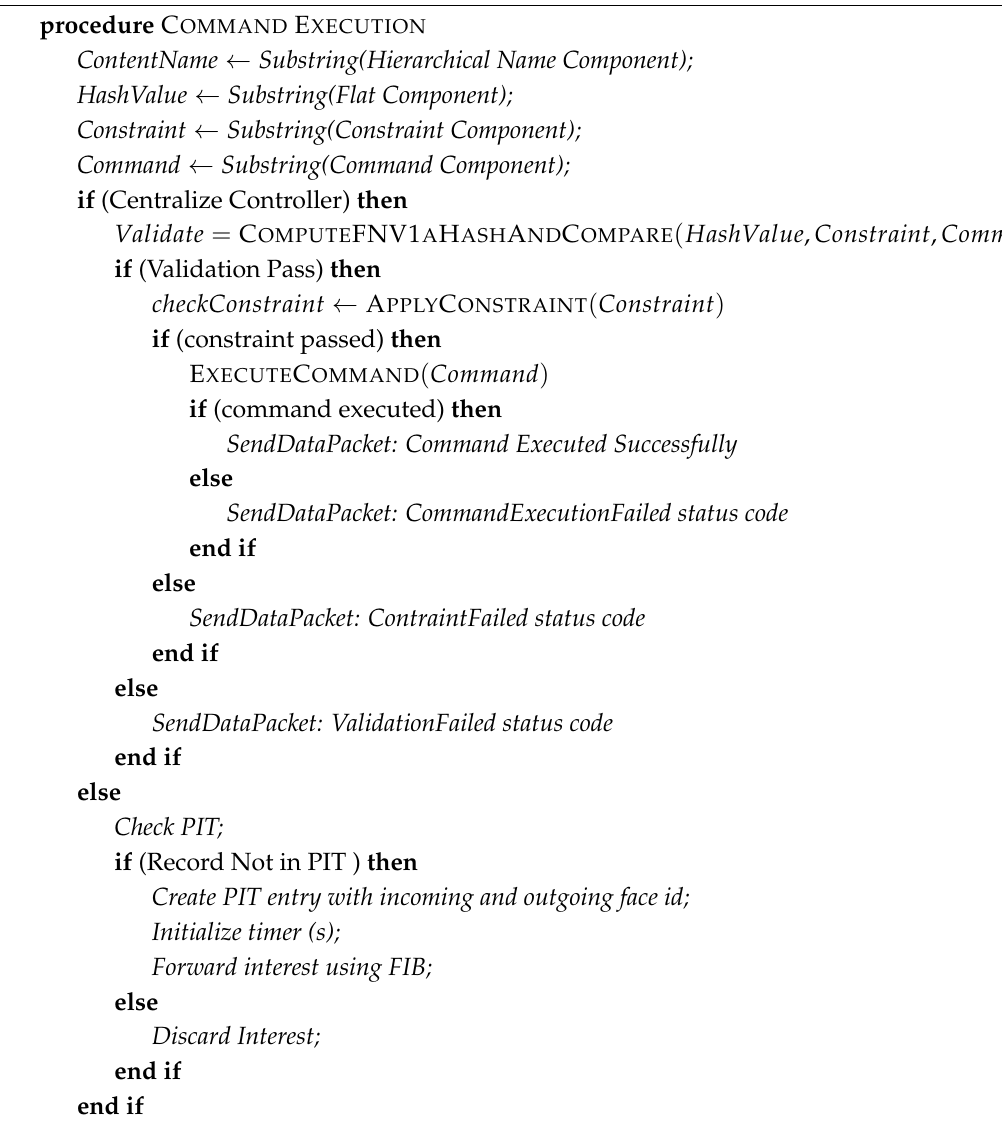
Algorithm 3 Received Interest (Command) in the Proposed NINQ procedure C OMMAND E